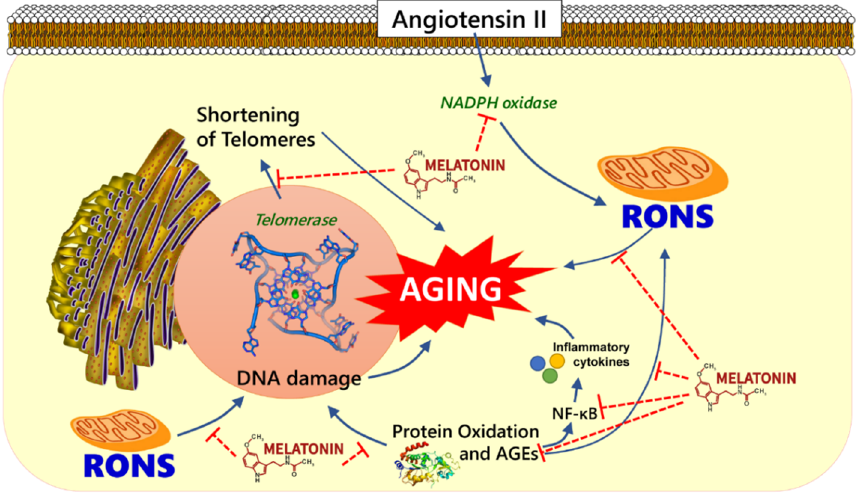
Figure 1. Schematic demonstration of potential antiaging mechanism of melatonin. Melatonin could play a role on aging hallmarks e.g., melatonin may attenuate angiotensin-induced oxidative damage by suppressing the production of reactive oxygen and nitrogen species (RONS), inflammatory cytokines, advanced glycation end products (AGEs) and preventing telomere shortening.